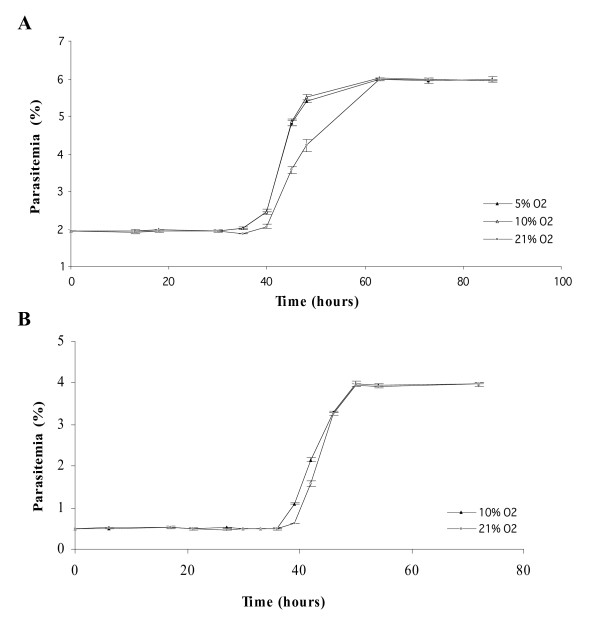
Evolution of asexual parasitaemia of synchronous cultures of Plasmodium falciparum under different oxygen tensions. Each point represents the mean ± standard deviation of three experiments. A: 3D7 clone. B: W2 clone.